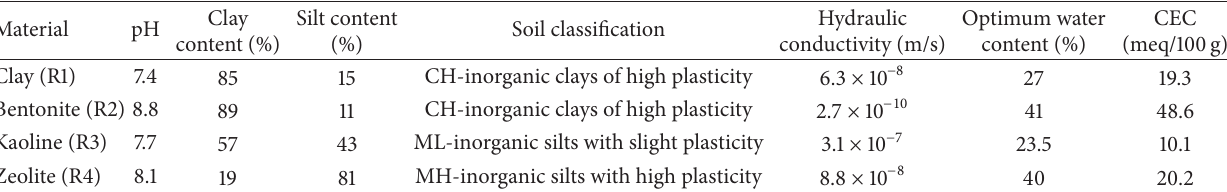
Table 2: Properties of the mineral materials used in the